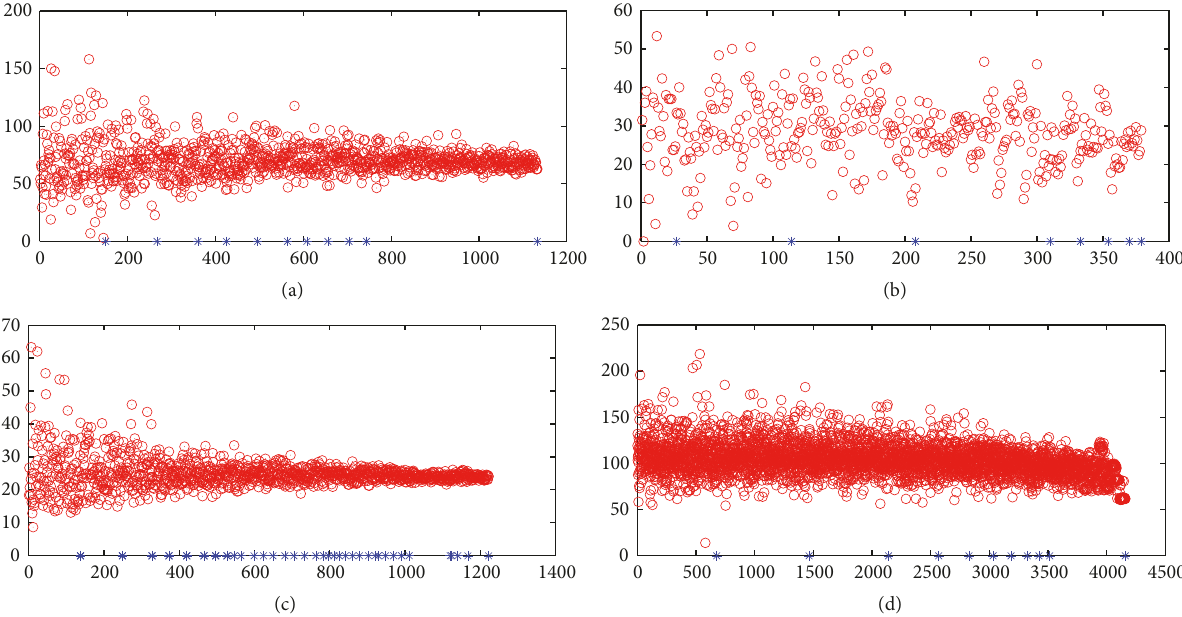
Figure 7: The average waiting time spent by each node from ignorant state to informed state on (a) Email-URV, (b) Netsci, (c) PolBlogs, and (d) Ca-GrQc, respectively.